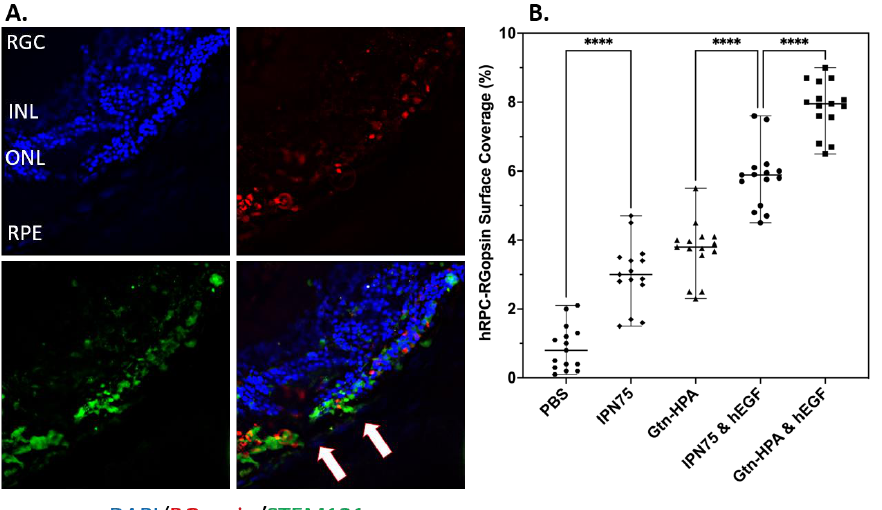
Figure 10. hRPCs survival, engraftment, and cone expression post-transplantation. ( A ) Immunohistochemistry of every 5th slide, for Gtn-HPA with hEGF group, stained with STEM121 (green), RG-opsin (red) and DAPI (blue). Scale bar: 200 µ m. ( B ) Statistical analysis, using one-way ANOVA, followed by Pearson’s test, of the percentage of cell (expressing RG-opsin) surface coverage in injected groups. **** p < 0.0001.